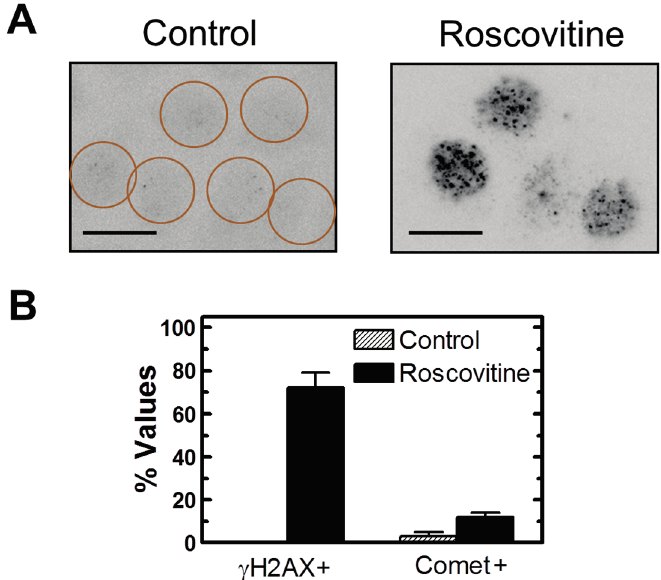
Figure 10. ( A ) Representative images showing the presence of γ H2AX foci in MCF7 cells treated with roscovitine (40 µM) for 24 h. Circles mark cells with low (background) levels of foci; Scale bar, 10 µm; ( B ) Influence of roscovitine treatment on percentages of cells with γ H2AX foci (exhibiting >5 foci/nucleus) and DSBs (exhibiting ≥ 10% fluorescence in comet tails). Bars,